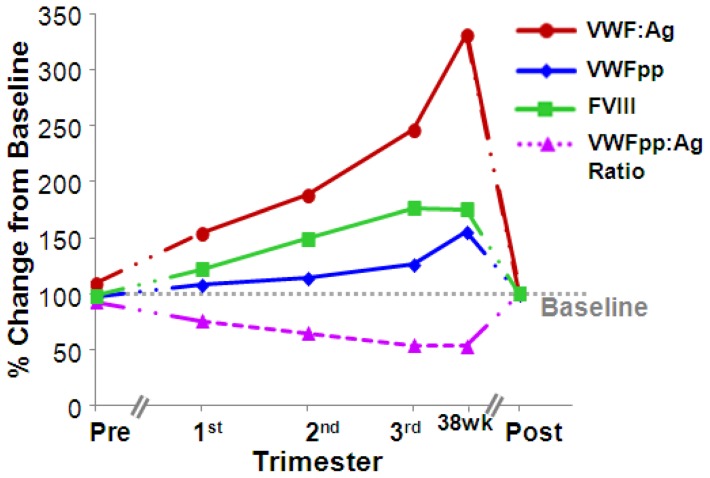
Changes in VWF-associated parameters from baseline in 46 pregnancies.The changes in VWF parameters normalized to baseline are displayed longitudinally over pregnancy for time points sampled in pre-pregnancy n = 14, 1st trimester n = 24, 2nd trimester n = 38, 3rd trimester n = 44, 38wks n = 12, and postpartum n = 41. Asterisks (*) indicate p<0.05 compared to postpartum values (one-way ANOVA, all pairwise multiple comparisons). Standard deviations, means, 25th, and 75th percentiles are omitted for clarity and can be found in Table 4.